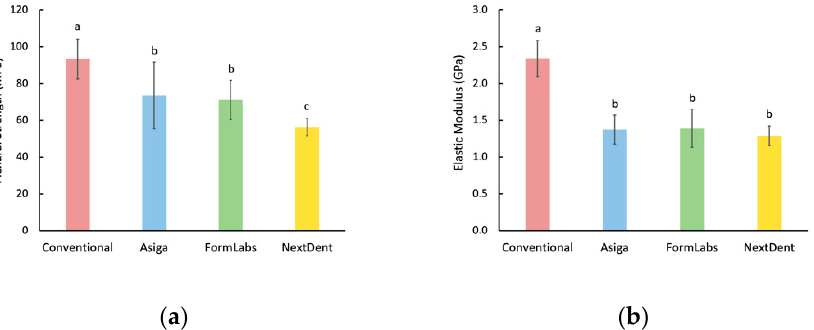
Figure 3. Flexural properties. ( a ) Flexural strength; ( b ) Elastic modulus. Similar letters indicate insignificant differences.